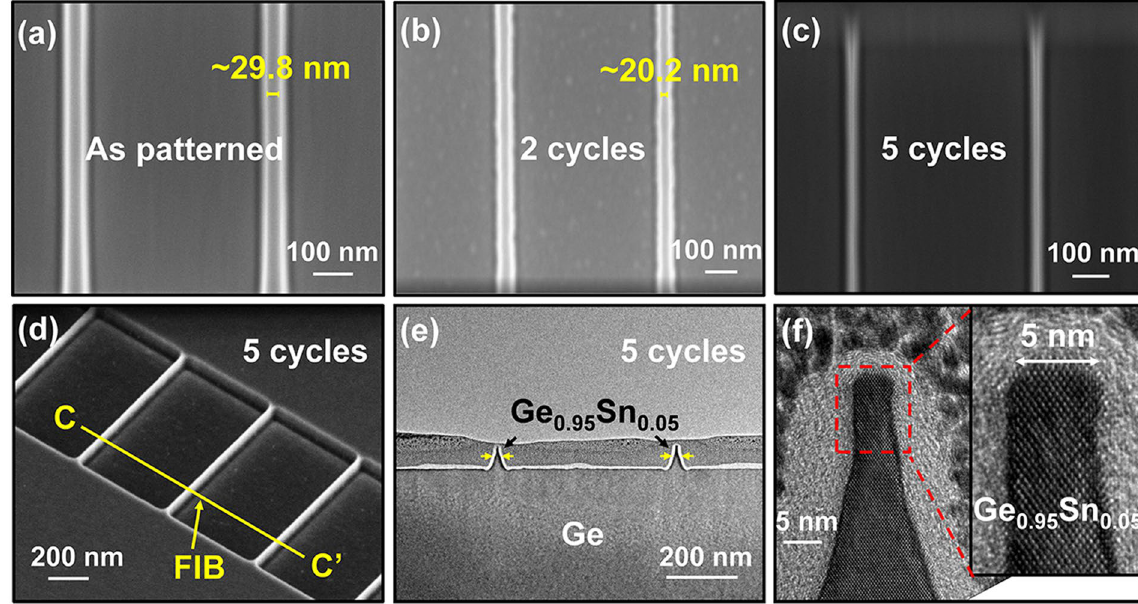
Figure 7. Top view SEM images of ( a ) the Ge 0.95 Sn 0.05 fins formation by EBL and Cl-based dry etch, and the Ge 0.95 Sn 0.05 fins after ( b ) 2-cycle and ( c ) 5-cycle digital etch. ( d ) Tilt view SEM image of the Ge 0.95 Sn 0.05 fins after 5-cycle digital etch. ( e ) XTEM and ( f ) HRTEM images demonstrate high crystalline quality Ge 0.95 Sn 0.05 fins with fin width of ~5